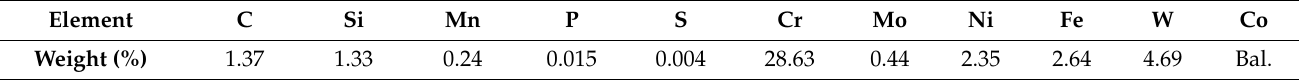
Figure 1. ( a – c ) SS304 with Stellite 6 cladding. The chemical composition of the Stellite 6 material is stated in Table 1. Table 1. Chemical composition of Stellite 6.